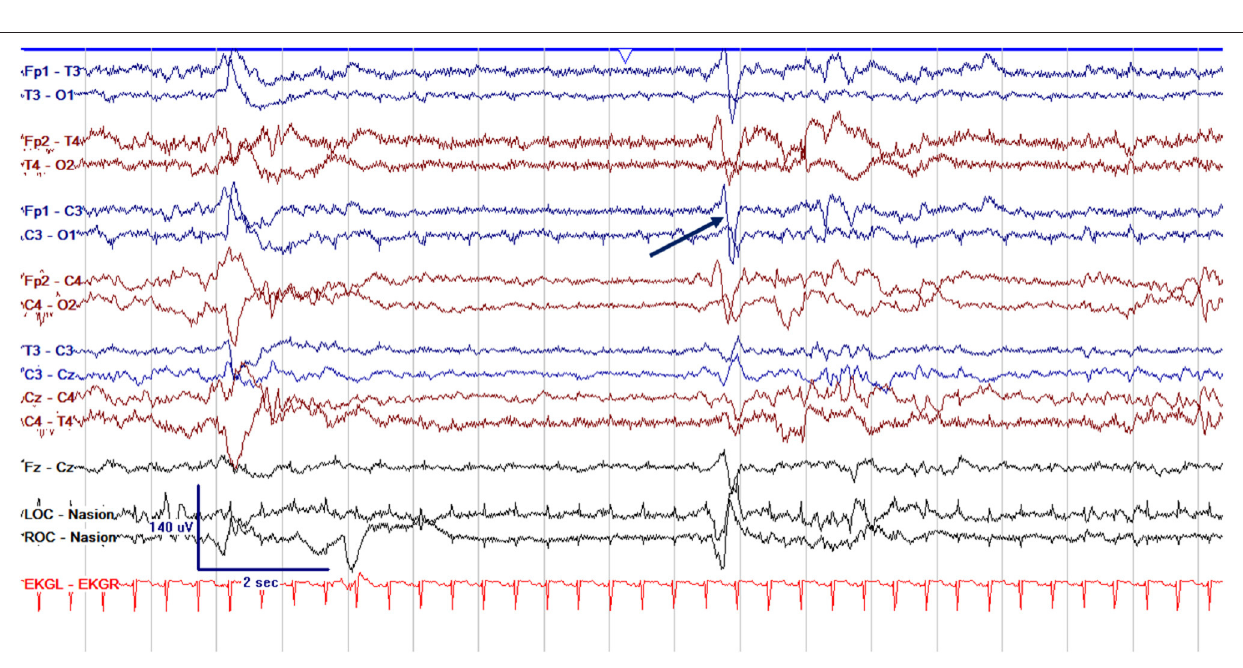
(7). A large meta-analysis found that EEG background patterns of burst suppression, low voltage, and flat trace were the most predictive of abnormal neurodevelopmental outcome, with pooled estimates of sensitivity and specificity of 87 and